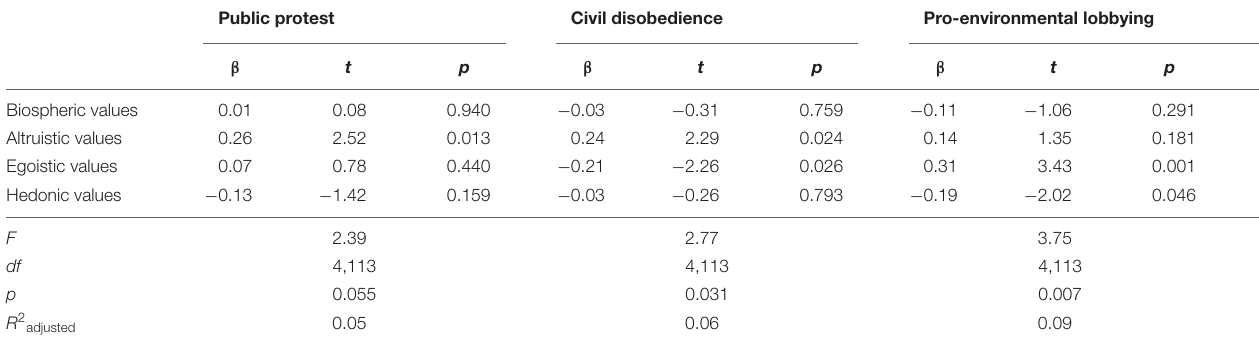
TABLE 3 | Regression models for other-directed social change actions (public protest, civil disobedience, and consultation with